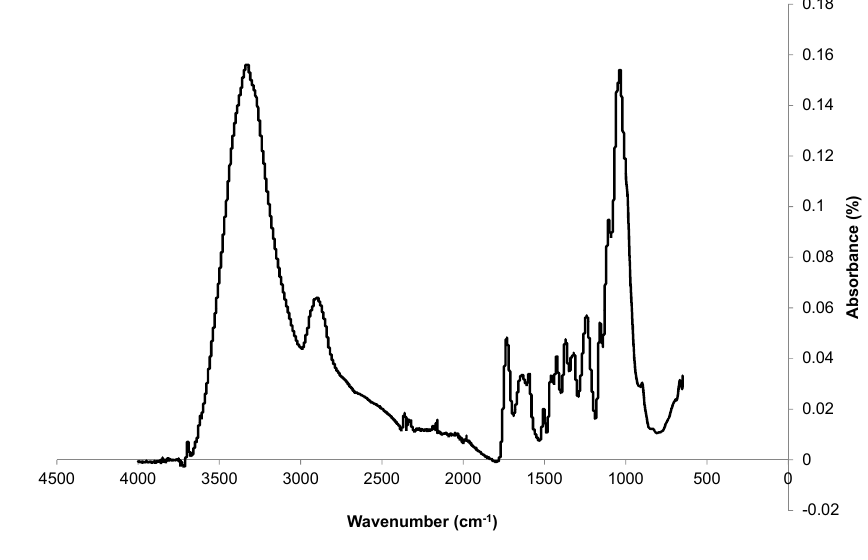
Figure 5. Infrared spectrum of the fibers.